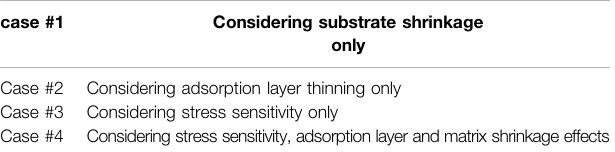
TABLE 5 | Different mechanisms in organic pores.